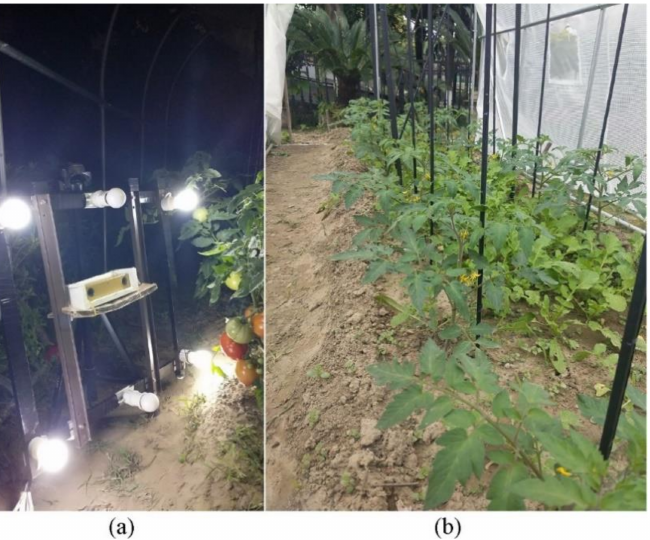
Figure 1. Night lighting system and planting environment: ( a ) night lighting system; ( b ) planting